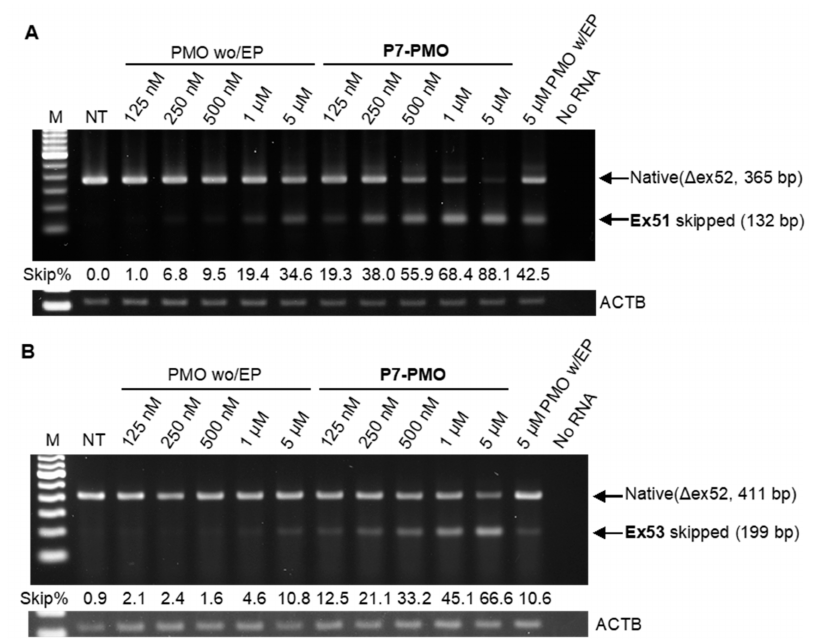
Figure 7. A cell-penetrating peptide (P7)-conjugation potentiates the in vitro efficacy of morpholinos (PMOs) at skipping exon 51 or 53 in the primary DMD ex52del pig muscle cells as represented by RT-PCR. ( A ) Exon 51 skipping efficiency comparison between unmodified PMO with or without a transfection agent, Endo-Porter (EP) at 6 µ M, and P7-peptide-conjugated PMO that have the Ac48 sequence. ( B ) Exon 53 skipping induced by Ac26-PMO with or without EP or with P7-conjugation. M, 100 bp marker; NT,